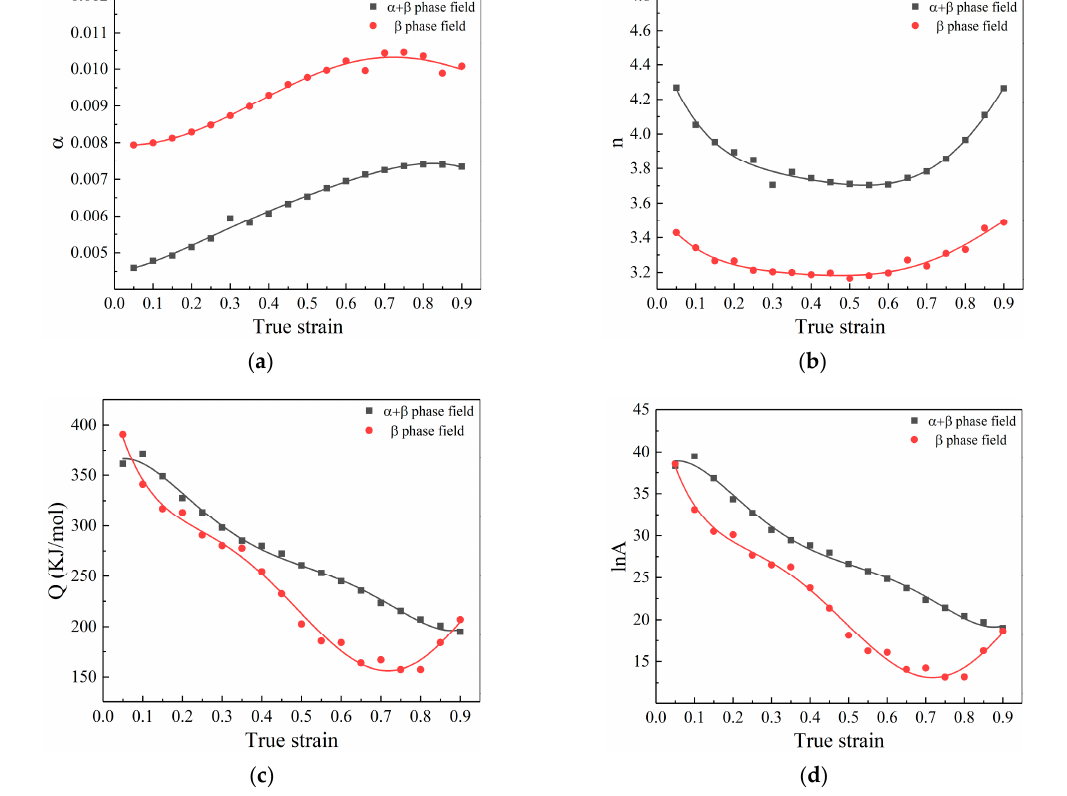
Figure 5. The fitted curves of ( a ) α ; ( b ) n; ( c ) Q; ( d ) lnA . Table 4. Polynomial fitting results of a, lnA, n, Q in α + β phase region.